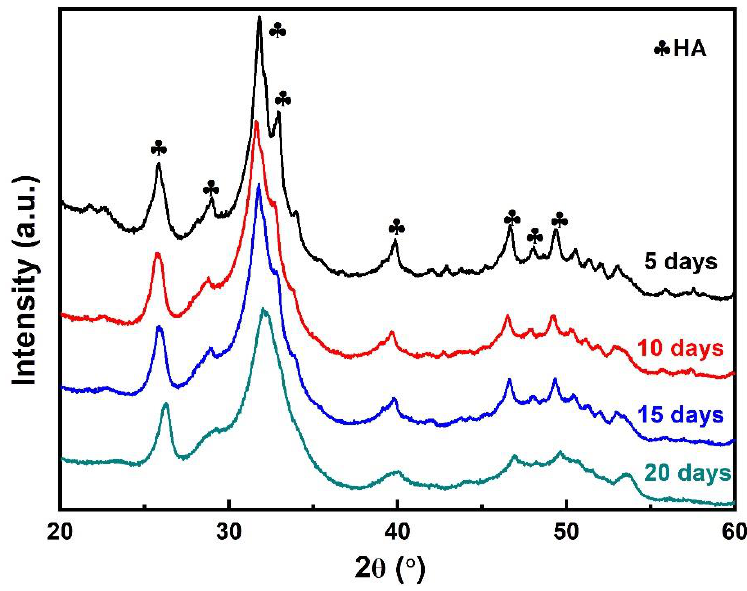
Figure 11. XRD patterns of MAO/APS coatings immersed for different numbers of days.